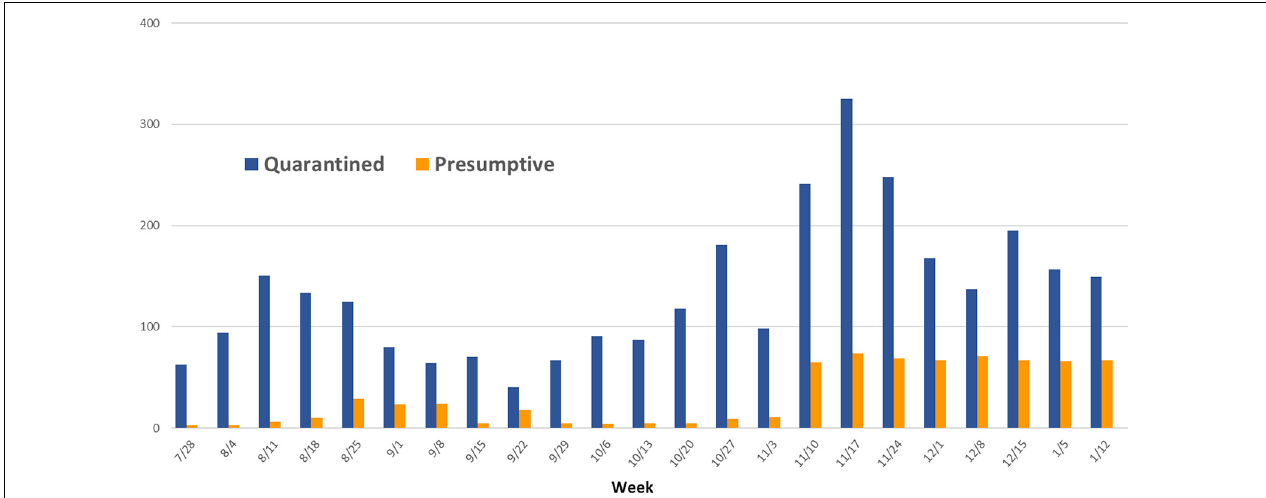
FIGURE 1 | Numbers of United States wildland firefighters quarantined and presumed infected with COVID-19 during the 2020 fire year. The number of cases was less than 200 between March and October, rising to 600 around the beginning of 2021 (Source: Nicole Williams, Deputy Pandemic Coordinator, United States Forest